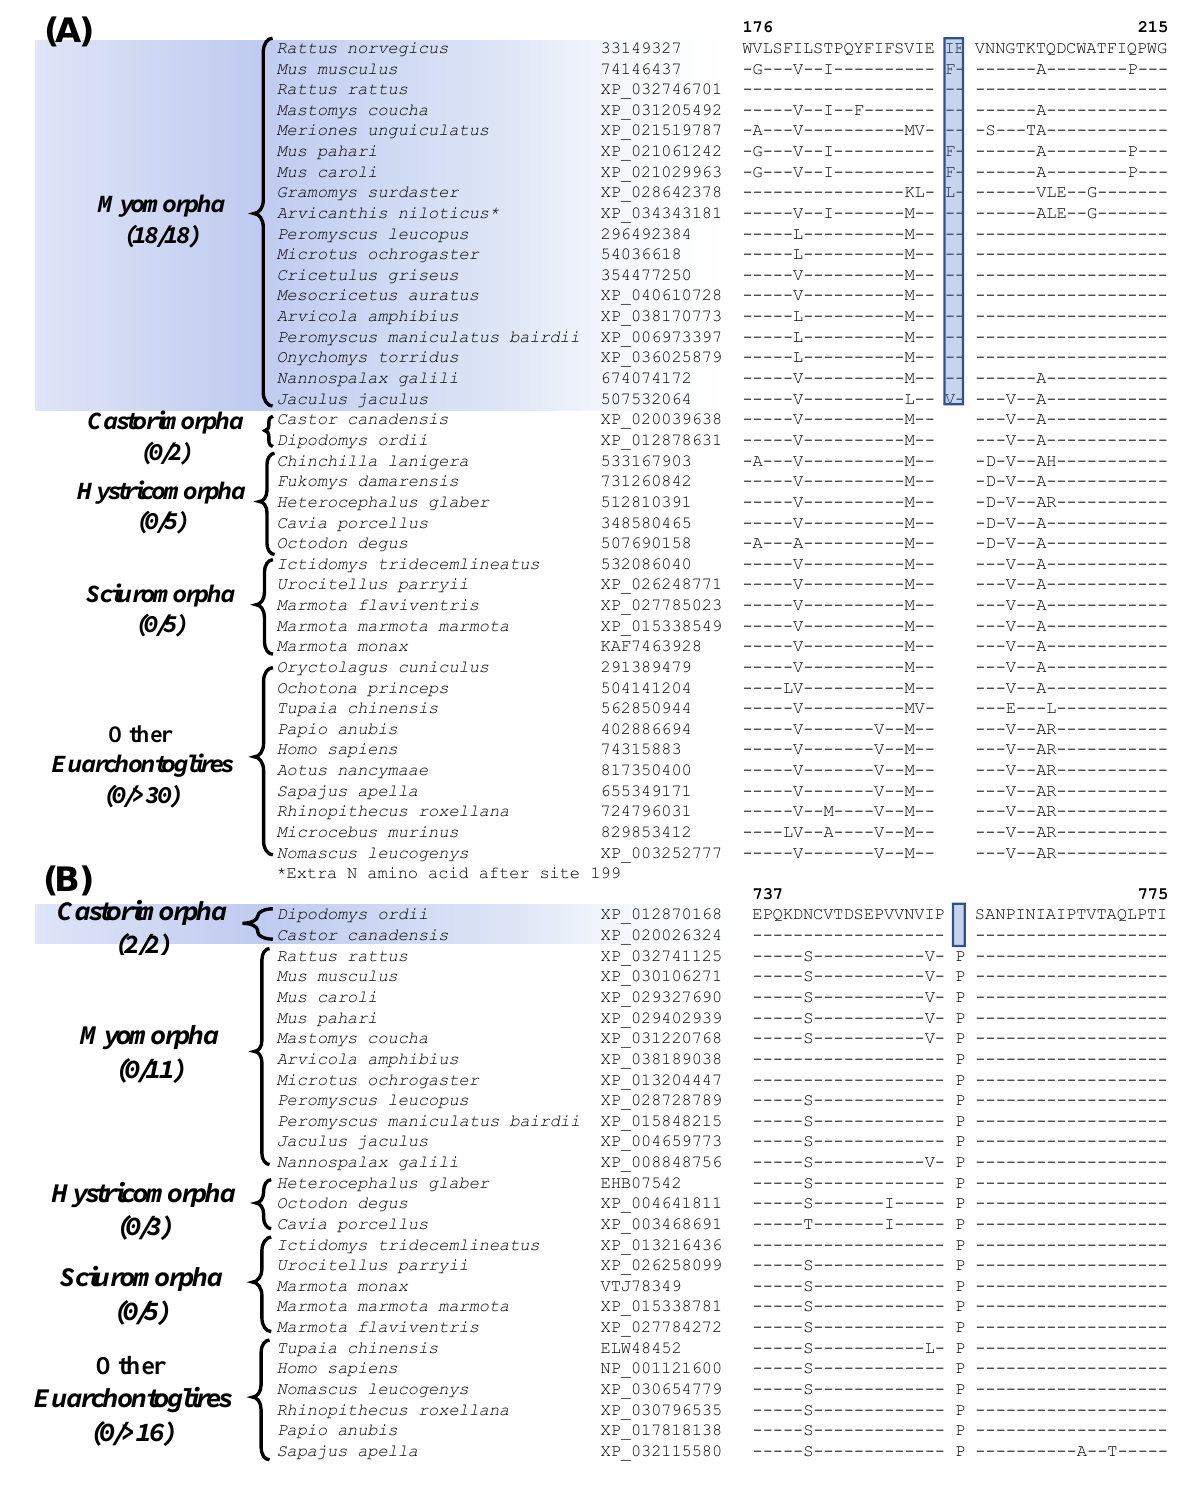
Figure 4. Partial sequence alignment of ( A ) the protein vasopressin V1a receptor, containing a 2 aa insertion that is specific for the suborder Myomorpha, and ( B ) the protein zinc finger E-box-binding homeobox 1, containing a 1 aa deletion that is specific for the suborder Castorimorpha. Other details are same as in Figure 1. Sequence information for additional CSIs specific for these two suborders are provided in Figures S8–S13 and summarized in Table